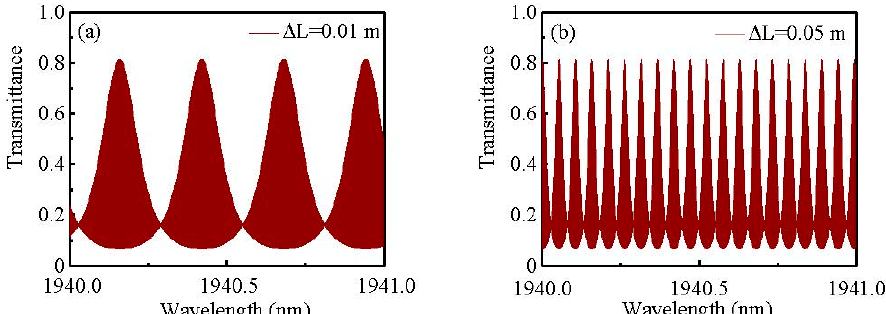
Figure 4. Simulated spectra of the proposed TCR-CC filter, with ( a , b ) showing the influence of sub-ring cavity length on the transmission performance.